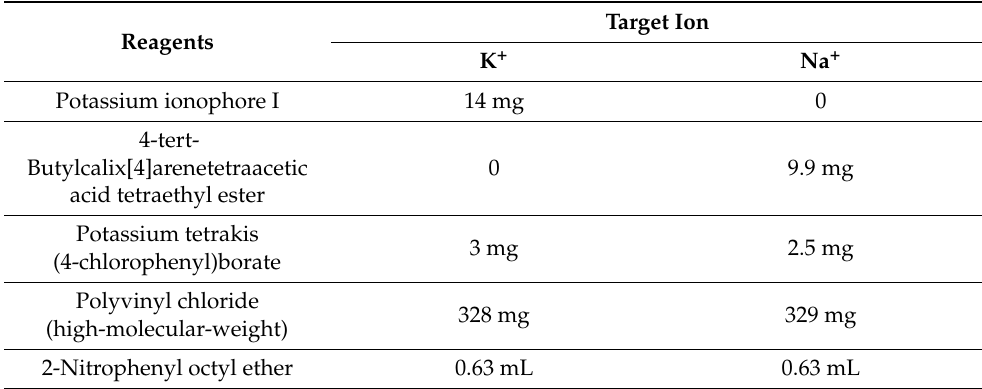
Table 1. Compositions and contents of potassium and sodium-ion-selective membrane.